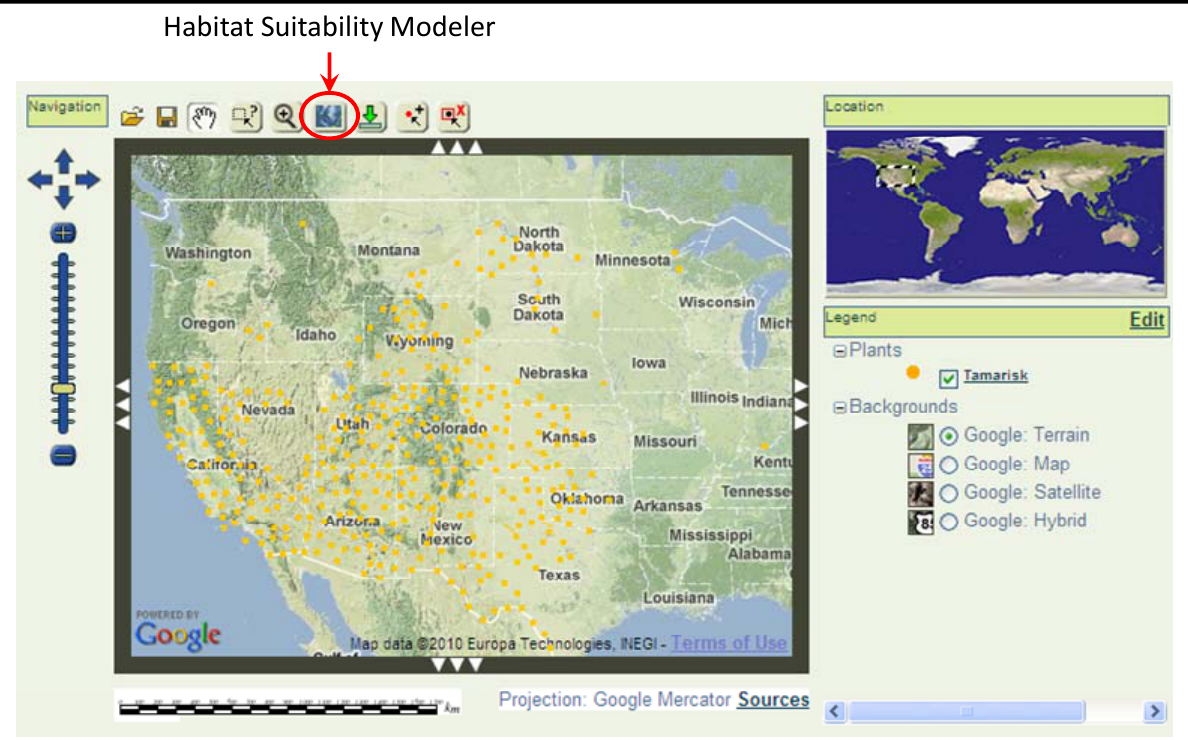
Figure 2. A screen capture of the mapping portion of the NIISS website with the Habitat Suitability Modeler button